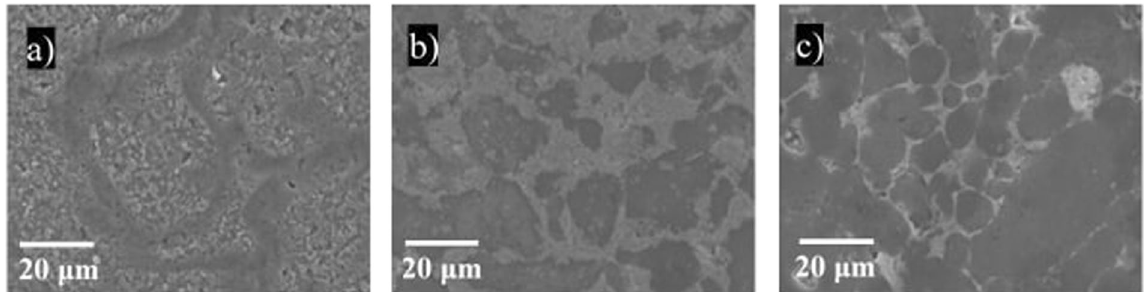
Figure 3. SEM images showing the structure of: ( a ) Aluminium, ( b ) Aluminium with 20 wt.% IF-WS 2 composite and ( c ) Aluminium with 20 wt.% 2H-WS 2 composite.